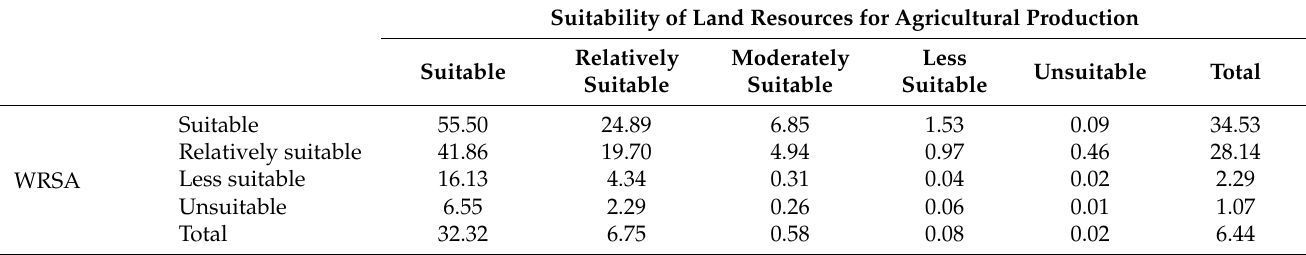
Table 5. Irrigated farmland density under different water and land resources suitability grades (%).